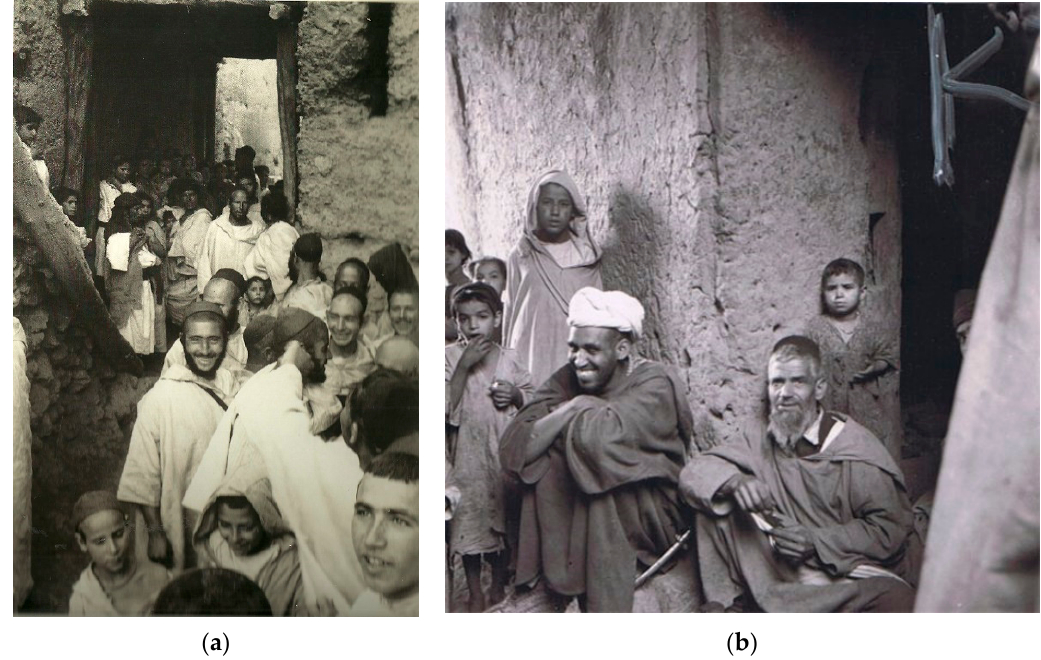
Figure 1. ( a ) Ait Bou Oulli mellah (photographer unknown), ( b ) Amezrou mellah , 1950 (Schulmann, Zédé),